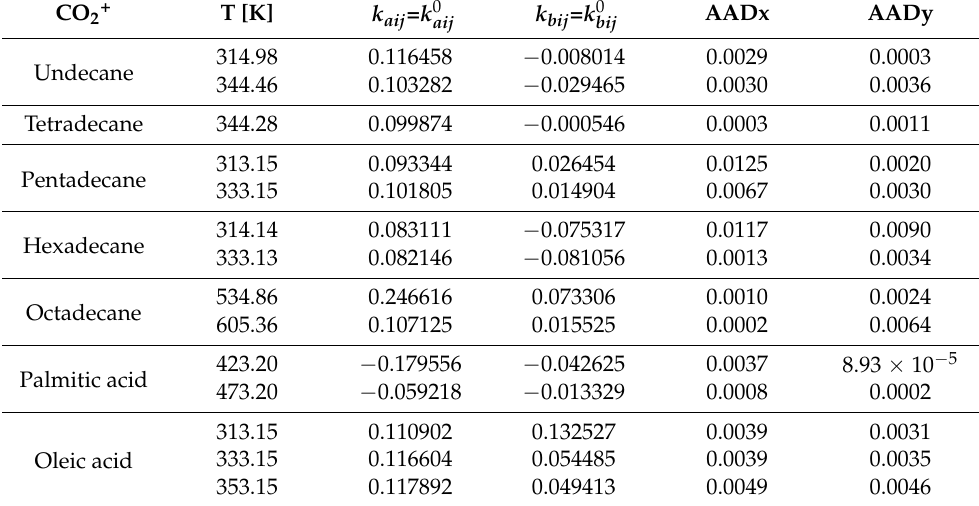
Table 11. RK-Aspen EOS temperature-independent binary interaction parameters adjusted with experimental phase equilibrium data for the binary systems hydrocarbons- i -CO 2 and carboxylic acids- i -CO 2 .